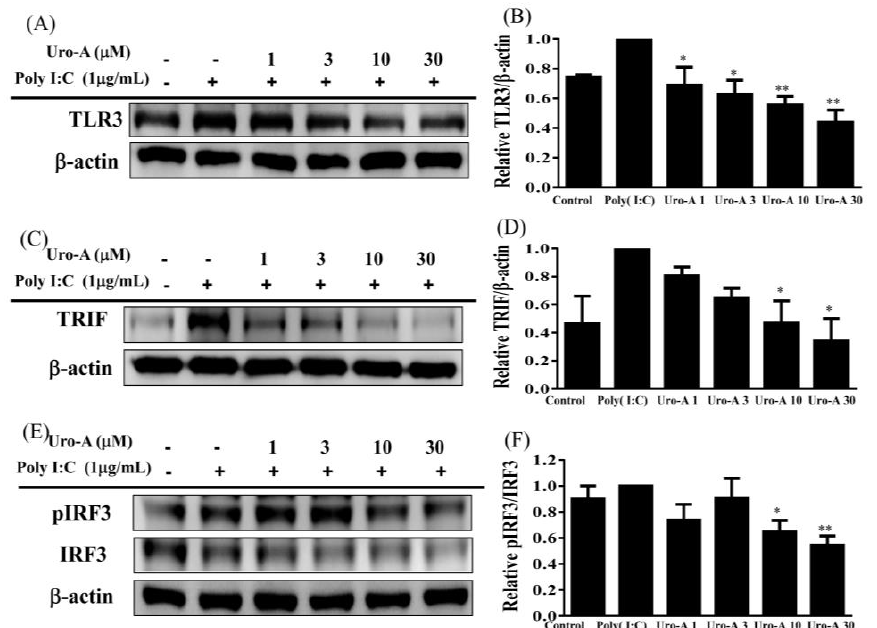
Figure 2. Urolithin A (Uro-A) suppressed TLR3 pathway protein expression in poly(I:C)-stimulated RAW264.7 cells. ( A ) TLR3 protein expression. ( B ) Fold-change in TLR3 expression relative to β -actin expression. ( C ) TRIF protein expression. ( D ) Fold–change in TRIF expression relative to β -actin expression. ( E ) pIRF3 and IRF3 protein expression. ( F ) Fold-change in pIRF3 expression relative to IRF3 expression. RAW264.7 cells were precultured with various concentrations of Uro-A, and then incubated with poly(I:C) (1 μ g/mL) for 30 min or 24 h. Data are presented as mean ± SD. * p < 0.05, ** p < 0.01 compared to RAW264.7 cells stimulated with poly(I:C) alone.